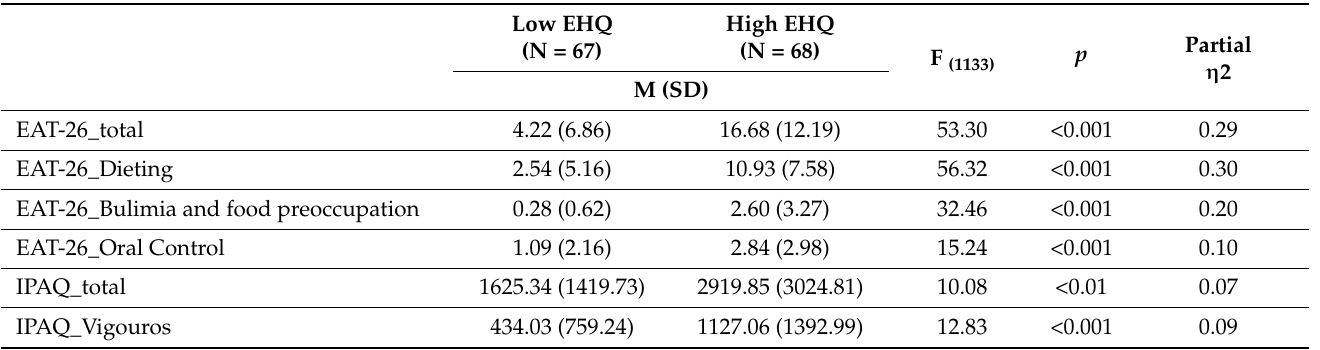
Table 4. Assessment of high versus low level of ON with disordered eating attitudes, self-esteem, and physical activity comparison among young adults: the significant